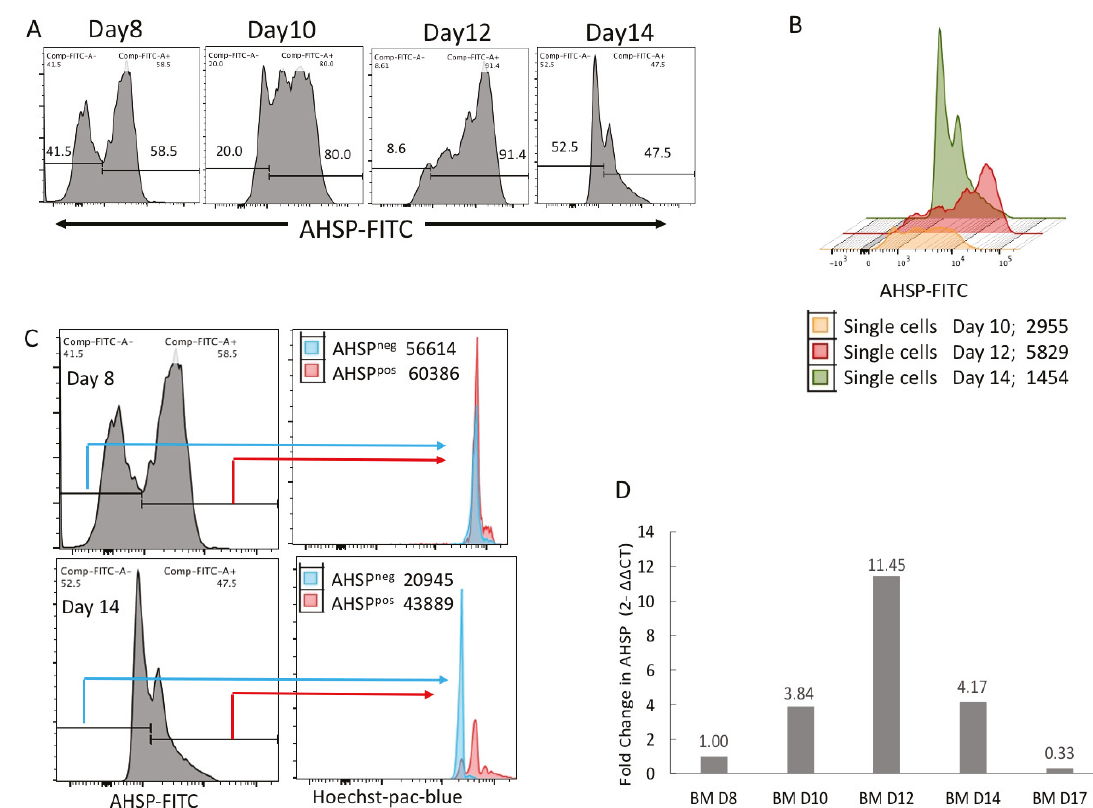
Figure 1. AHSP protein and gene expression in naïve human bone marrow derived erythroblasts. ( A ) Percentage of AHSP positive and negative cells in fluorescence-activated cell sorting (FACS) analysis on culture days 8, 10, 12 and 14. ( B ) Overlay of AHSP protein expression displayed with color graphs on Day 10 (orange), Day 12 (red) and Day 14 (green) showing that the highest mean fluorescent intensity (MFI) shifted to the right on Day 12. ( C ) AHSP positive and negative subsets from culture days 8 and 14 stratified by Hoechst nuclear stain mean fluorescent intensity. ( D ) Relative gene expression of AHSP in total erythroblasts on culture days 8, 10, 12, 14 and 17. Bar graphs represent fold change compared to culture day 8. Target gene cycle threshold (Ct) values were normalized to GAPDH Ct values using the ∆∆ Ct